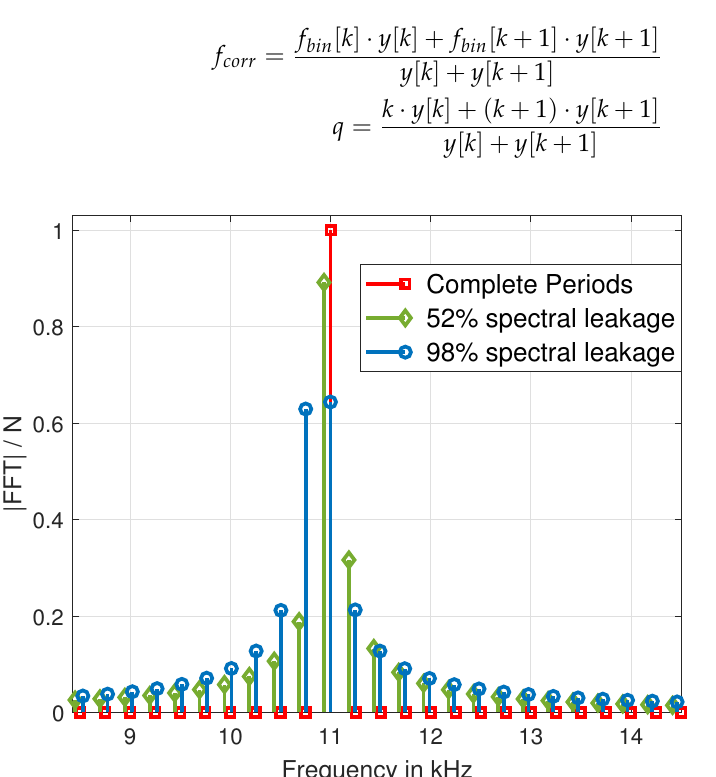
Figure 1. Influence of Incomplete Signal on the Single-side Discrete Fourier Analysis for a Sam- ple 11 kHz Signal with a Complete Last Period, Quarter-complete Period (52% Spectral Leakage), and Half-complete Period (98% Spectral